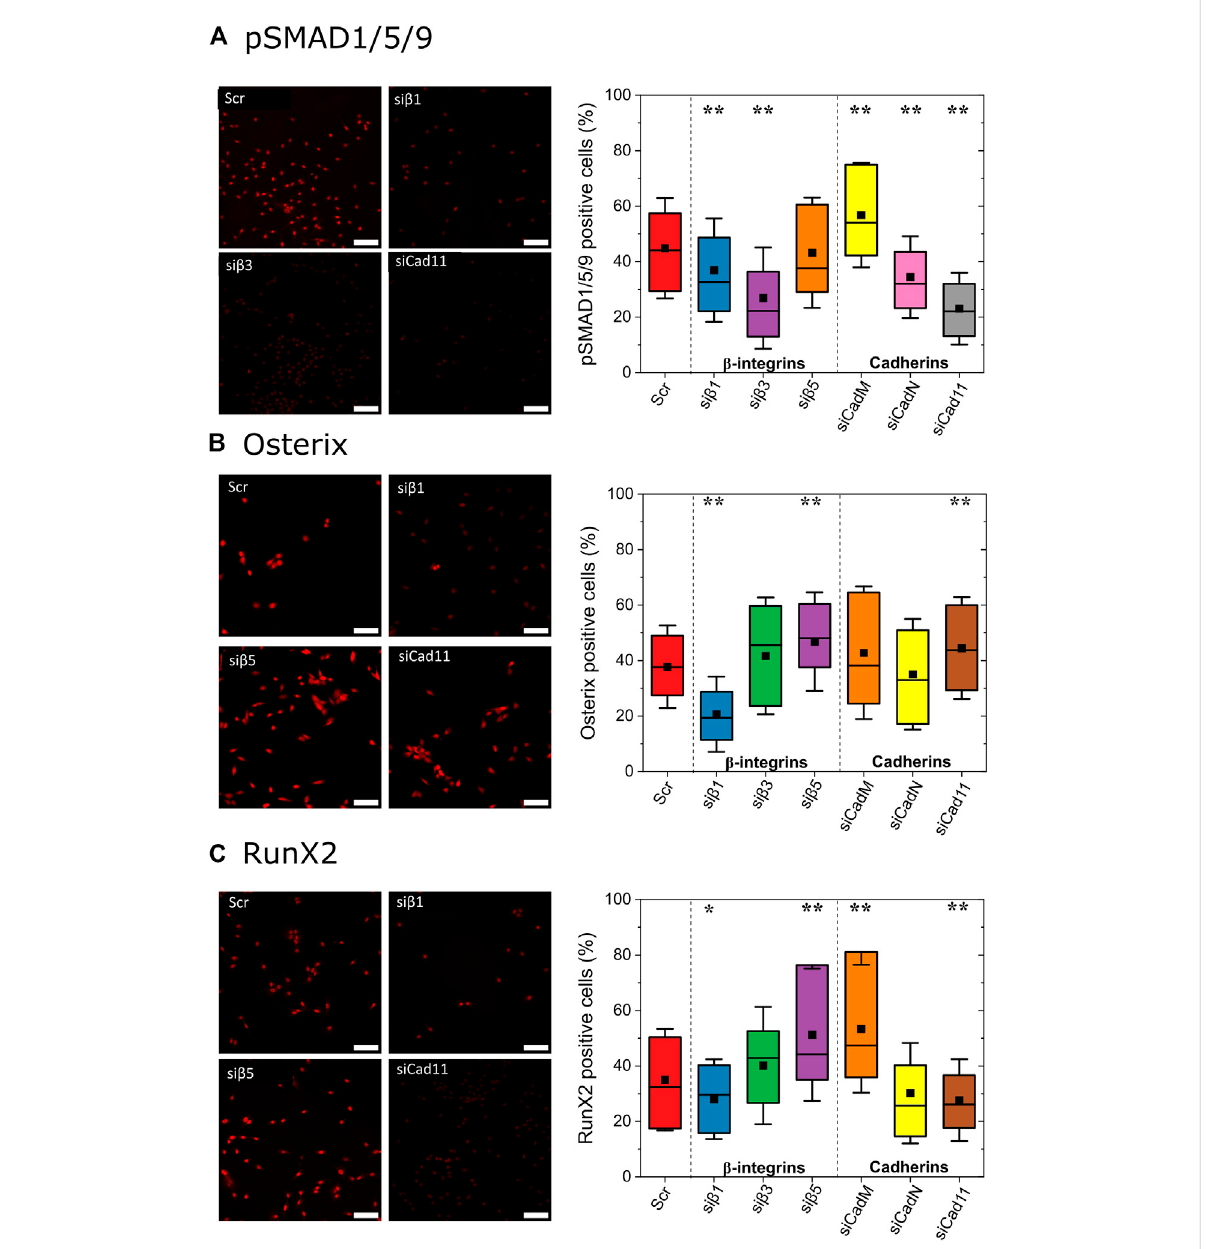
FIGURE 6 Role of β chain integrins and cadherins on the nuclear localization of transcription factors involved in osteoblast differentiation. Using RNA interference, silencing of the major integrins ( β 1, 3, 5 subunits) and cadherins (M-cad, N-cad, cad11) was done to assess their individual role on the nuclear localization of (A) pSMAD1,5,9, (B) Osterix and (C) Runx2, for cells cultured on fi lms with bBMP-2. Representative images are shown for selected conditions that have the strongest effects on the nuclear localization of the transcription factor. Scale bar of fl uorescent images is 100 µm. Data are represented as box plots for three independent experiments. Statistical tests were done using non-parametric Kruskal – Wallis ANOVA (* p < 0.05; ** p <